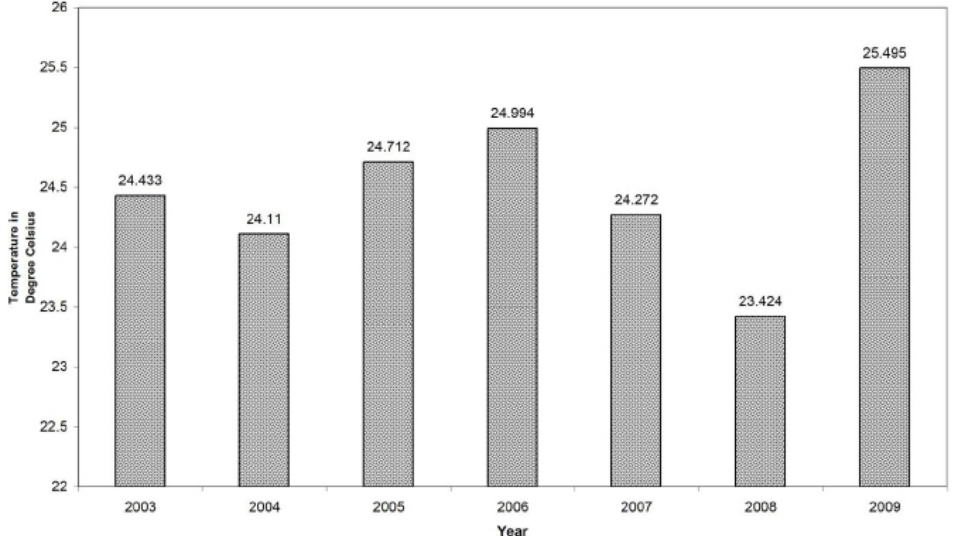
Figure 3. Change of SST in the month of February from 2003 to 2009 around the study area (1˚ ×